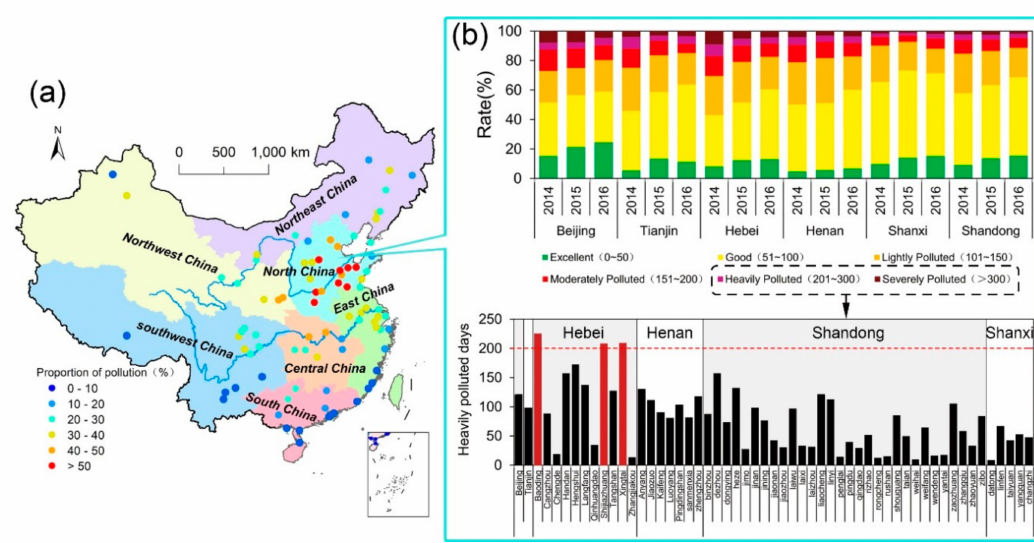
Figure 2. Proportions of di ff erent categories of air pollution for cities in China (2014–2016). ( a ) The AQI in North China is the highest in the country and is much higher than elsewhere in China. ( b ) The composition of AQI for each province in North China.